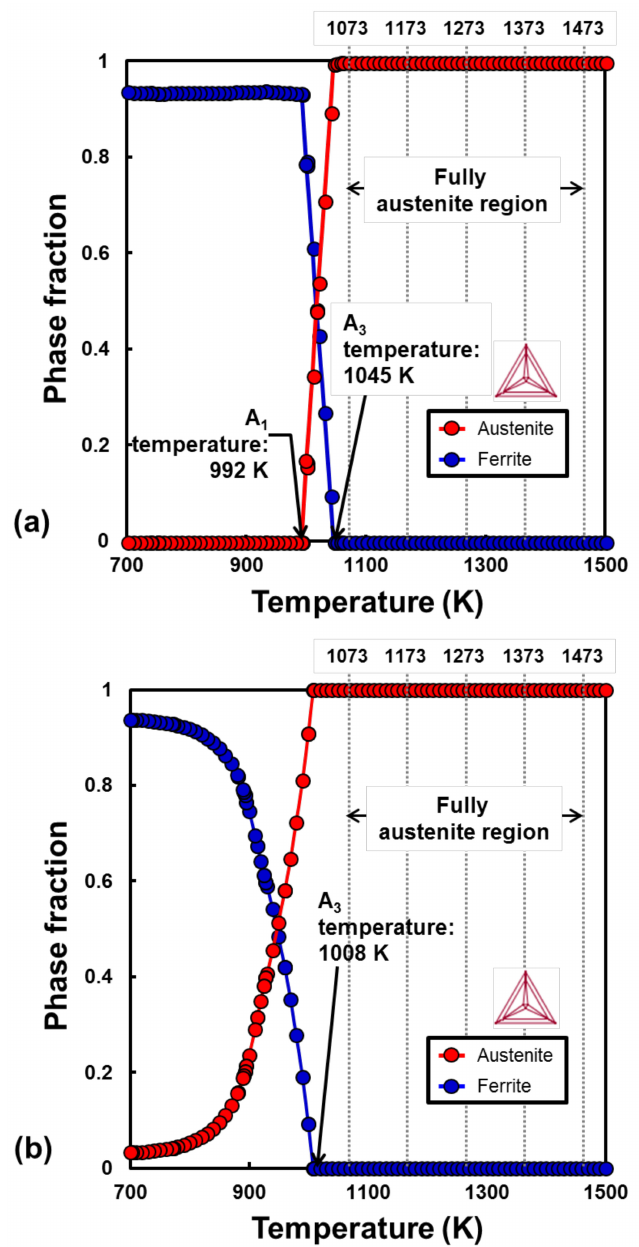
Figure 4. Thermodynamic calculations of phase fraction as a function of temperature for ( a ) P20-improved steel and ( b ) P21